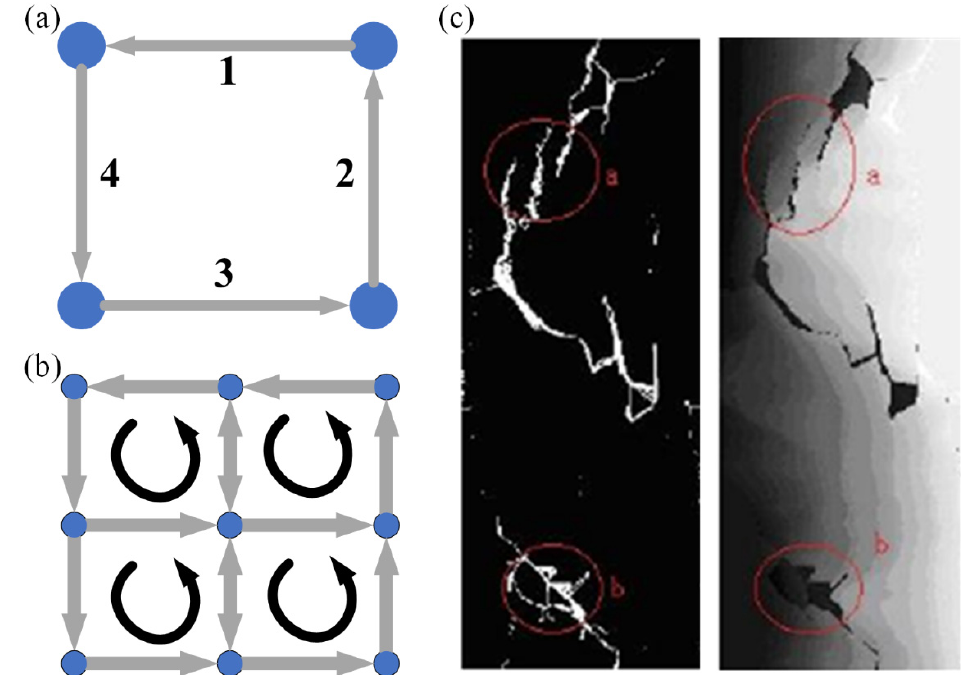
Figure 1. Flow chart of determining the residual, branch tangent, and phase unwrapping according to the residual. ( a ). The 2 × 2 closed loop element in the phase data matrix. ( b ). The 3 × 3 closed loop element. ( c ). Branches cut distribution and phase unrolled diagram.